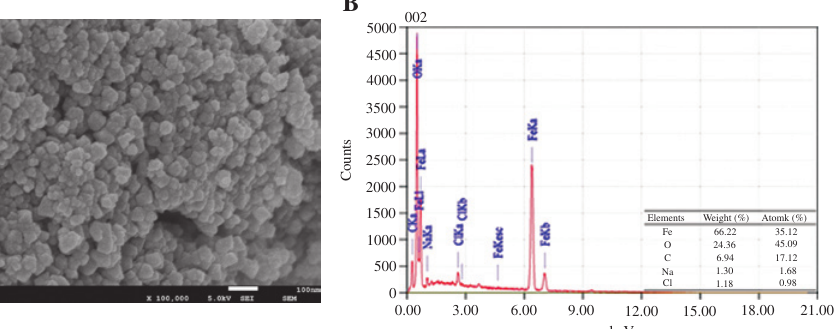
Figure 6: (A) The scanning electron microscopic (SEM) micrograph and (B) energy dispersive X-ray (EDX) spectra of the phytogenic magnetic nanoparticles (PMNPs).